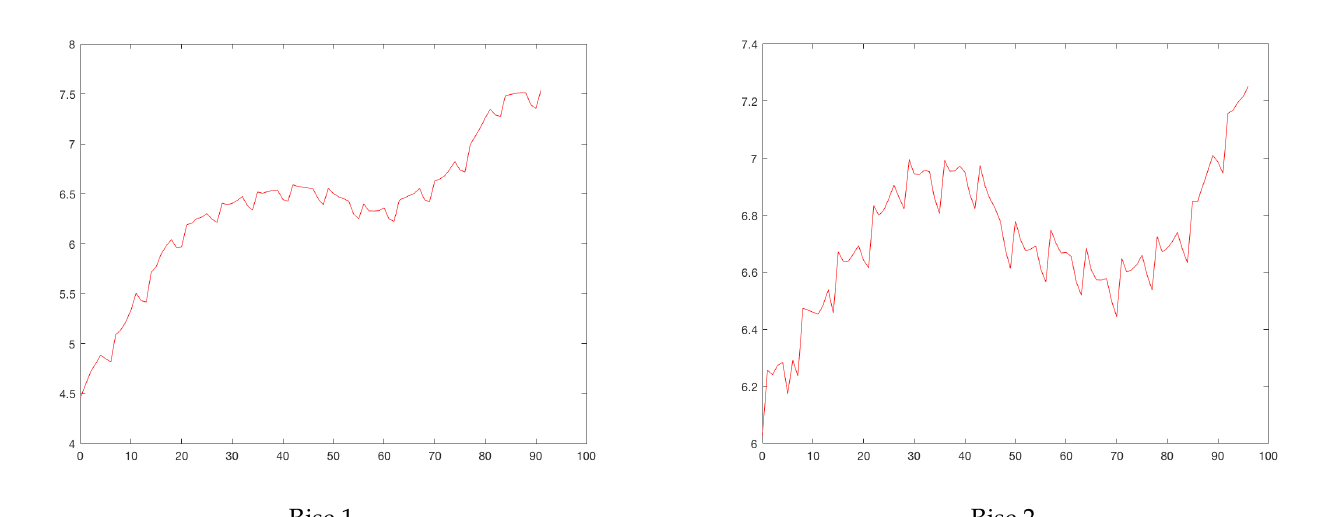
Figure A16. Marseille’s rises. Horizontal axis, days; vertical axis: logarithm of daily cases.